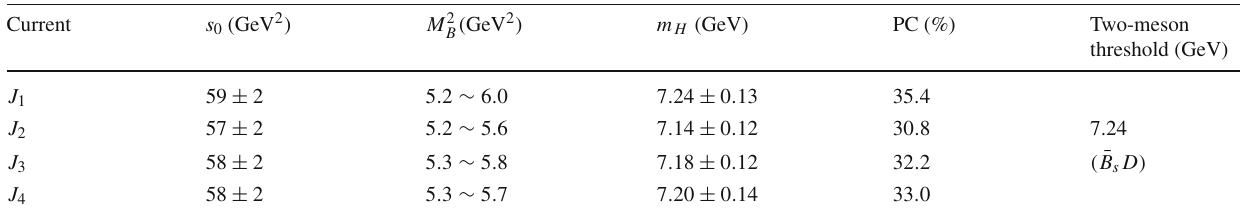
Table 1 The continuum threshold, Borel window, hadron mass and pole contribution for the bc ¯ q ¯ s system with J P = 0 +